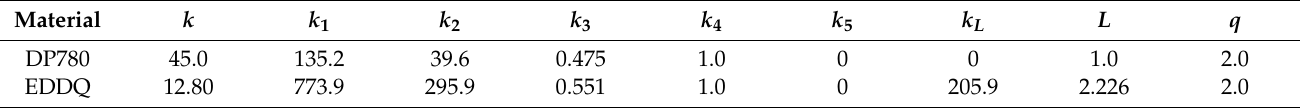
Table 3. Coefficients of HAH-2d models for DP780 and